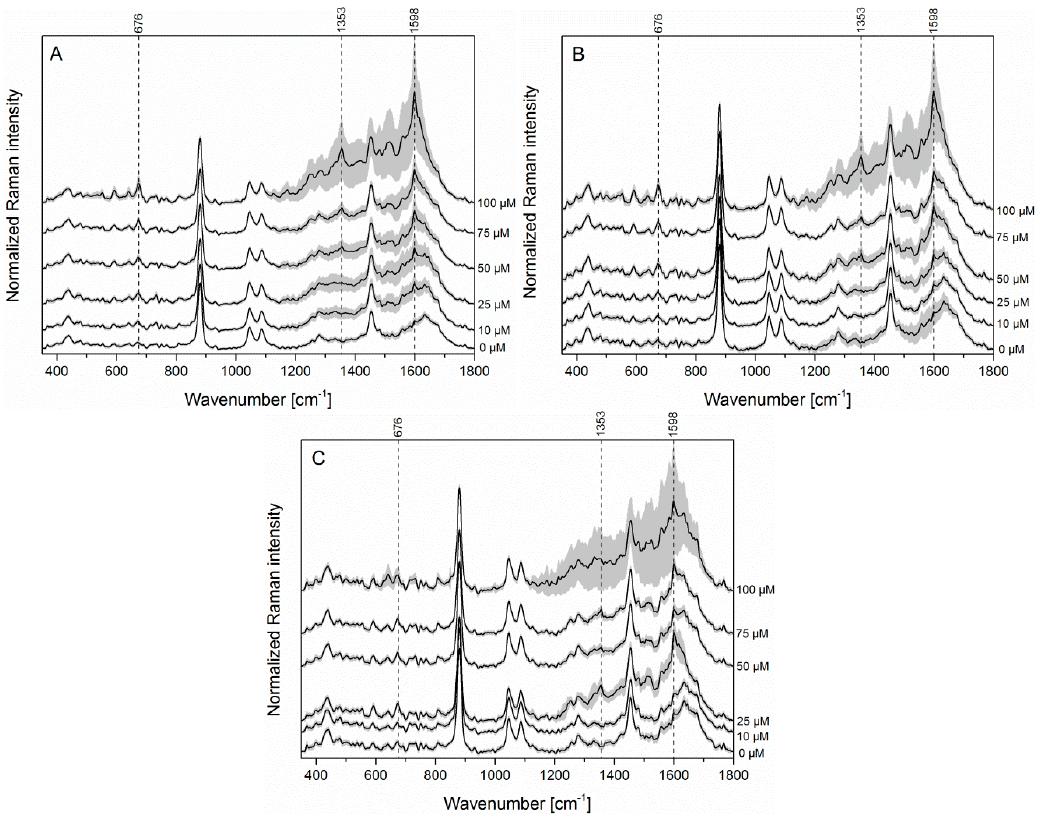
Figure 5. Mean SERS spectra and their double standard deviation of the different concentrations of PYO in the saliva sample from volunteer number one ( A ), two ( B ) and three ( C ).